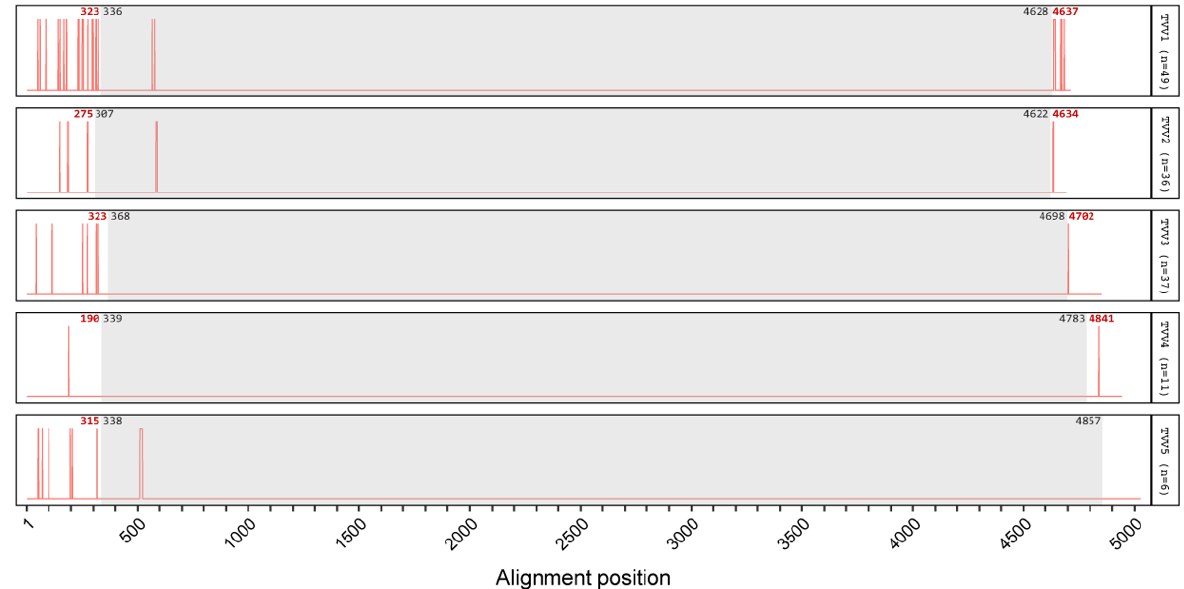
Figure 2. Gap plots showing all indels across the aligned nt sequences of TVV1 through TVV5 strains. Indels are concentrated in the 5´ and 3´ UTRs, although gapless regions also found within the UTRs suggest conserved functional elements. For each trichomonasvirus species, new assemblies were combined with all coding-complete and partial sequences from NCBI GenBank and aligned using MAFFT L-INS-i. The unsequenced ends of partial sequences in the multiple sequence alignment were masked to prevent bias from missing residues. The alignment was analyzed with a custom R script. Gray boxes denote the CDS for the CP/RdRp of each species. Gap positions are indicated by red bars. Red numbers indicate the gap position nearest each CDS boundary; black numbers indicate the CDS boundary positions.